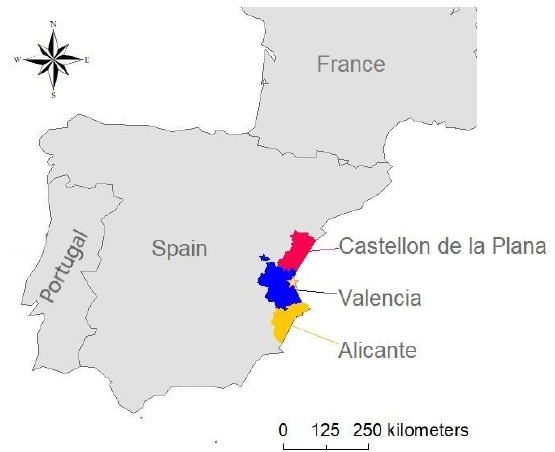
Figure 1. The Valencian community, its three provinces (Castellon de la Plana, Valencia, and Alicante), in Spain.